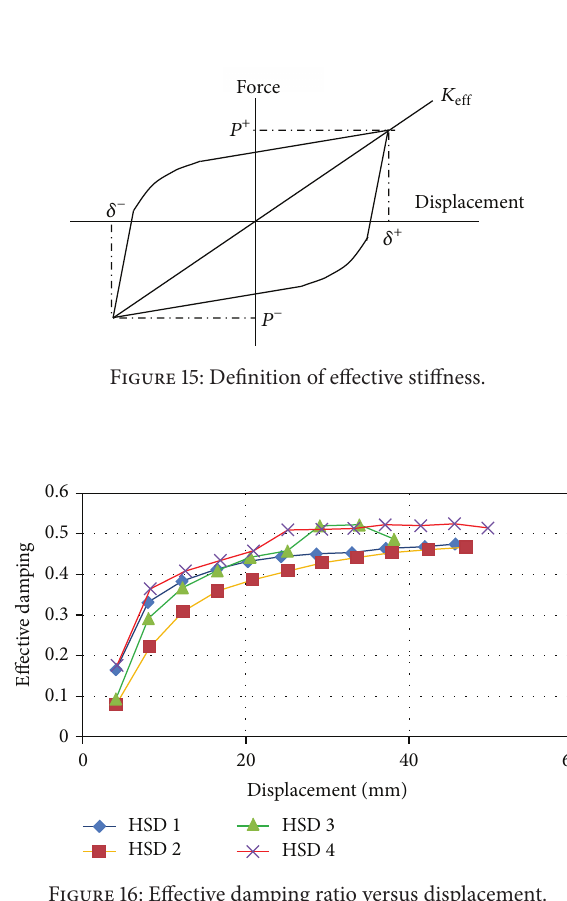
Figure 16: Effective damping ratio versus displacement.